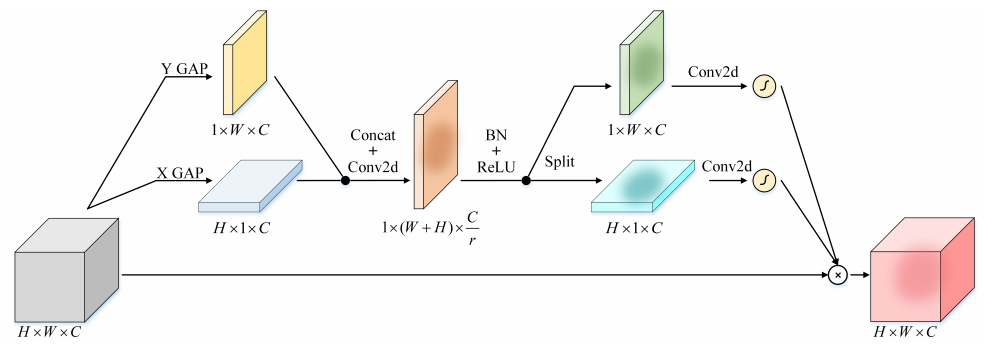
Figure 29. Coordinate Attention (CA)